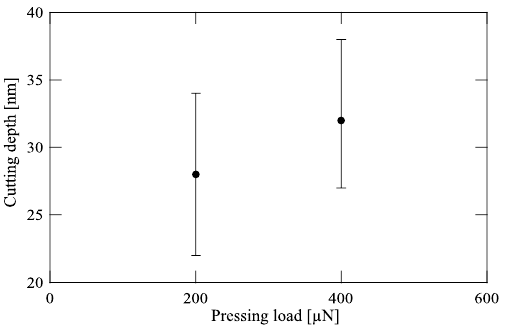
Figure 6. Depths for the holes I and III are the average values for all sectional views for each hole. The hole I was cut under application of a 200 µ N pressing load at an excitation frequency of 15.41 kHz which is the natural frequency under the pressing load of 200 µ N. The hole III was cut under application of a 400 µ N pressing load at an excitation frequency of 15.49 kHz which is the natural frequency under the pressing load of 400 µ N.